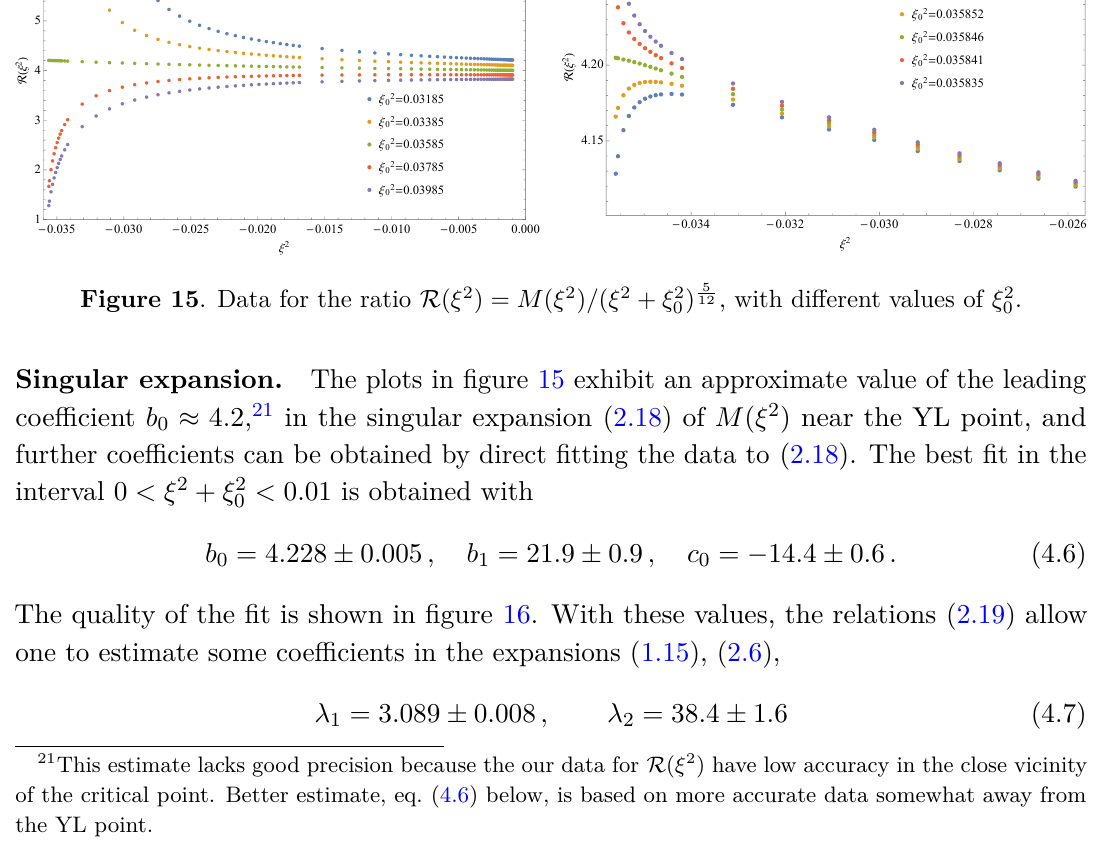
Figure 15 . Data for the ratio R ( ξ 2 ) = M ( ξ 2 ) / ( ξ 2 + ξ 2